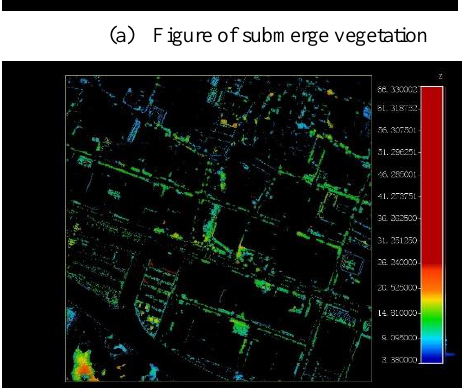
(a) Figure of submerge vegetation